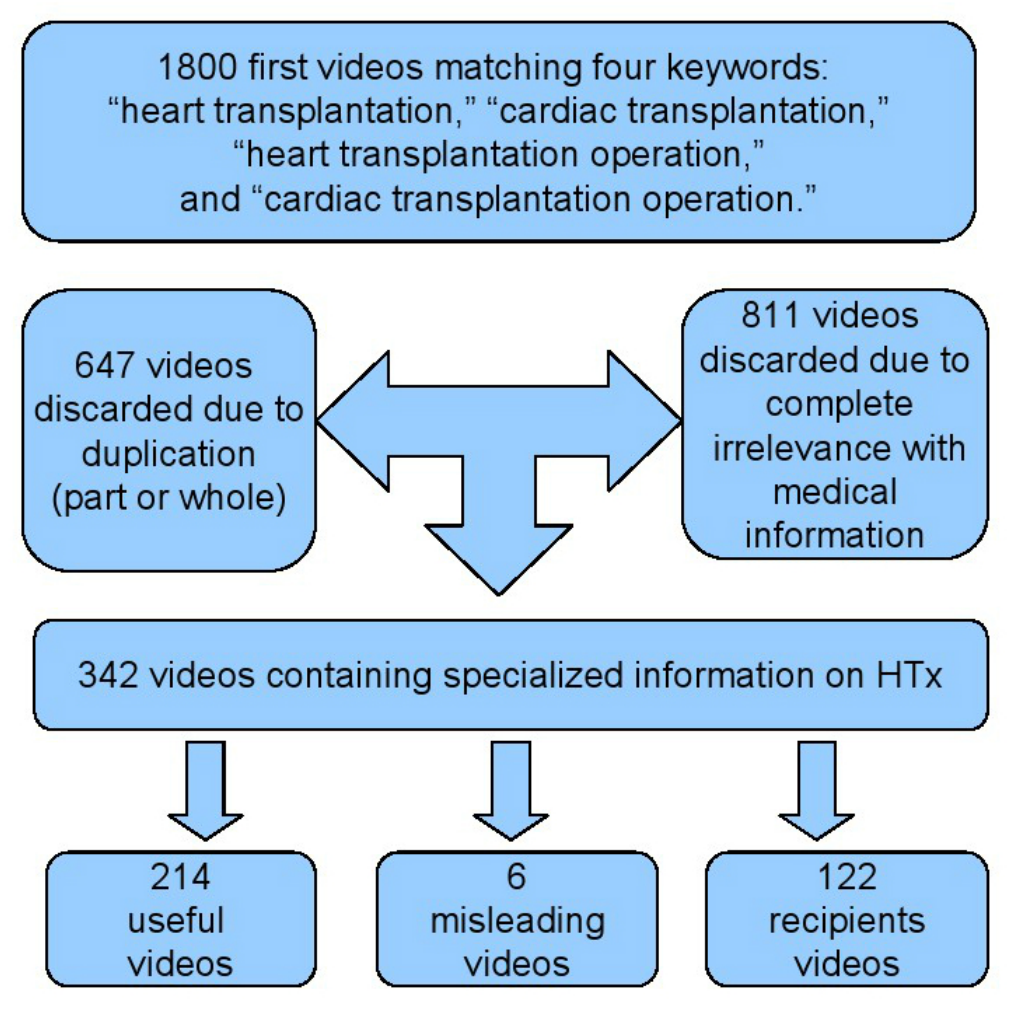
Figure 1. A graphic display of the classifying process of HTx-related